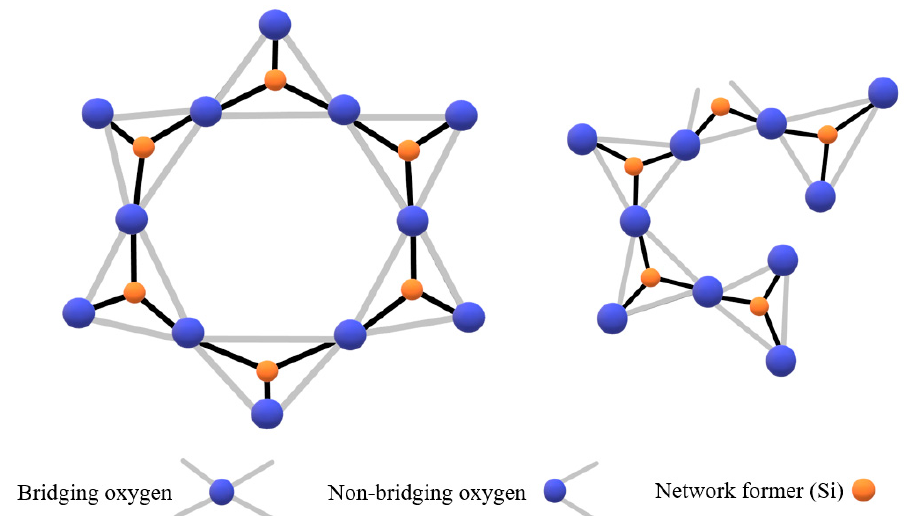
Figure 16. Network of Si-O tetrahedral in ( a ) crystalline and ( b ) molten slag [21].